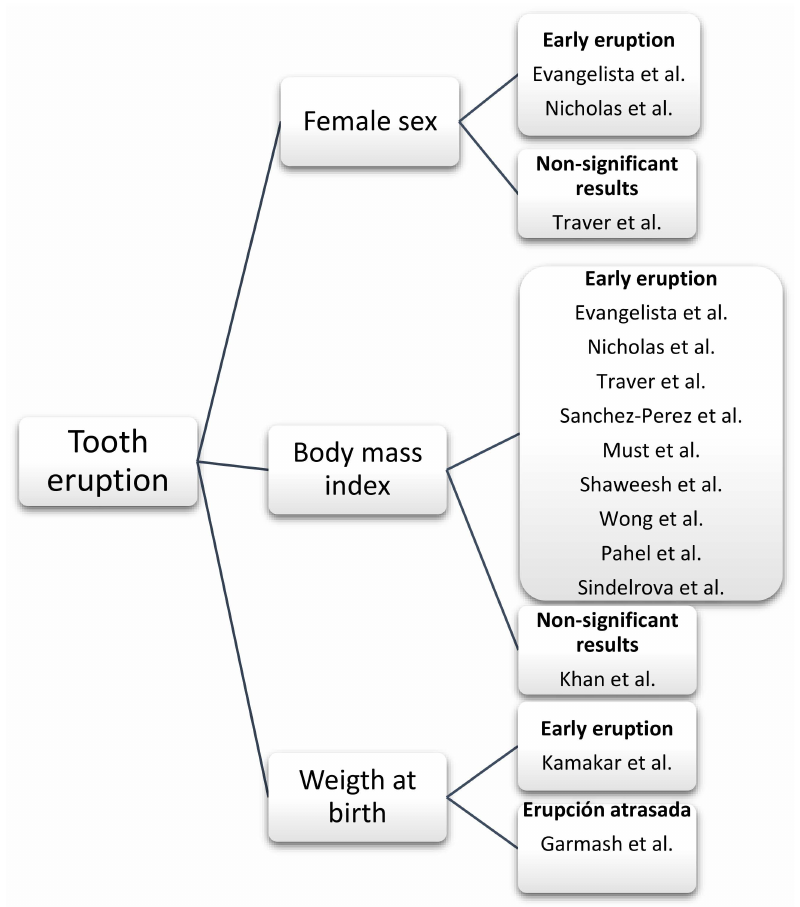
Figure 2. Relationship between obesity and non-molecular factors